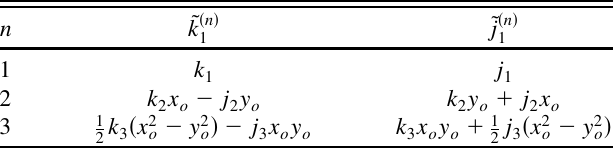
TABLE I. Leading three orders of the feed-down due to the deformed closed